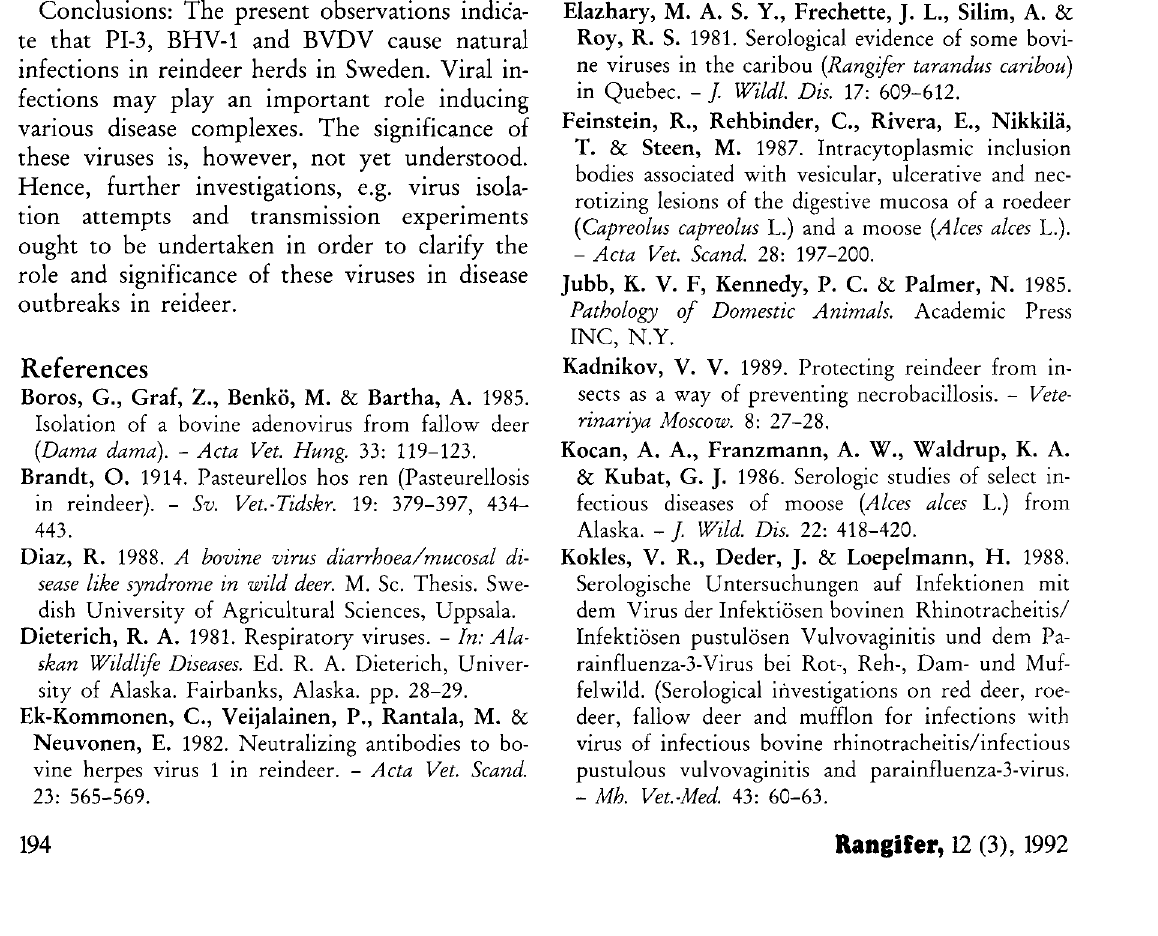
Fig. 2. Cataract in